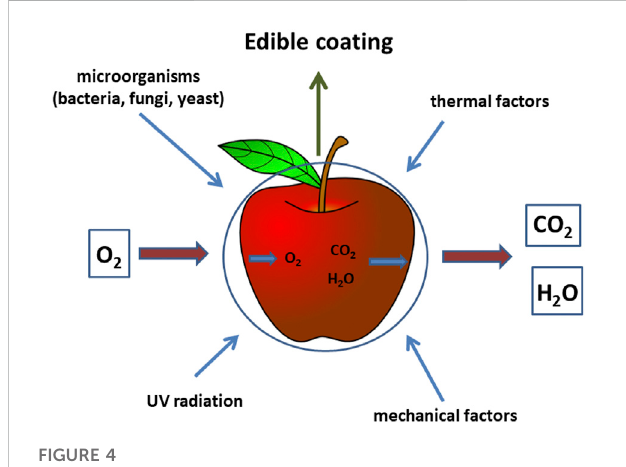
FIGURE 4 Role of nanocoatings in food production.